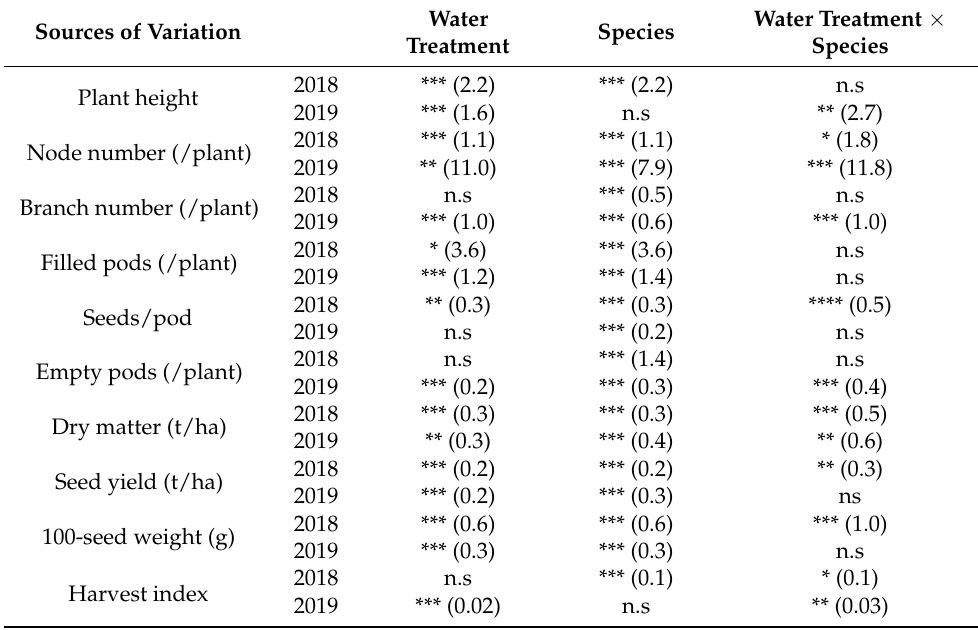
Table 1. Significance of sources of variation for water treatment, species, and their interactions. There were three water treatments at the Vemase site (2018) and two water treatments at the Laleia site (2019), and three grain legumes at each site. n.s. not significant, * p ≤ 0.05, ** p ≤ 0.01, *** p ≤ 0.001. Least significant differences of means (LSD) values at p = 0.05 are in parenthesis. Water Treatment × Water Species Sources of Variation Species Treatment 2018 *** (2.2) *** (2.2) n.s Plant height Node number